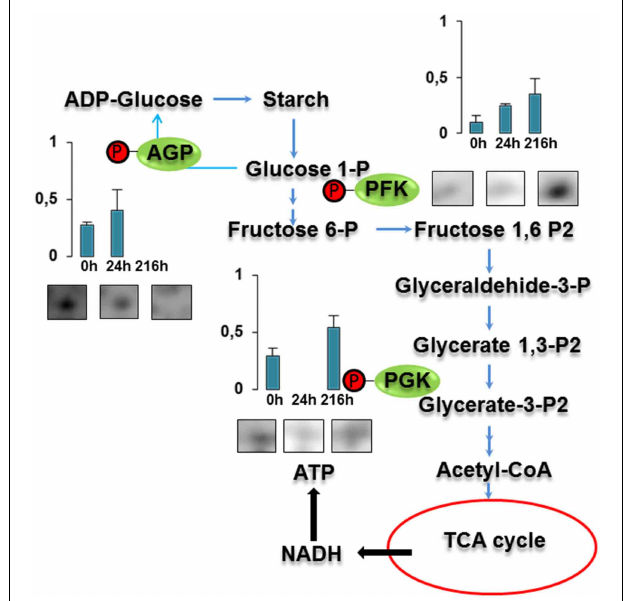
FIGURE 3 | Carbohydrate metabolic pathway constructed with proteins whose phosphorylation changed. Proteins are represented by a green circle. The figures represent the normalized spots volume vs. analyzed stages of each protein, also shown is the spot volume in the stages